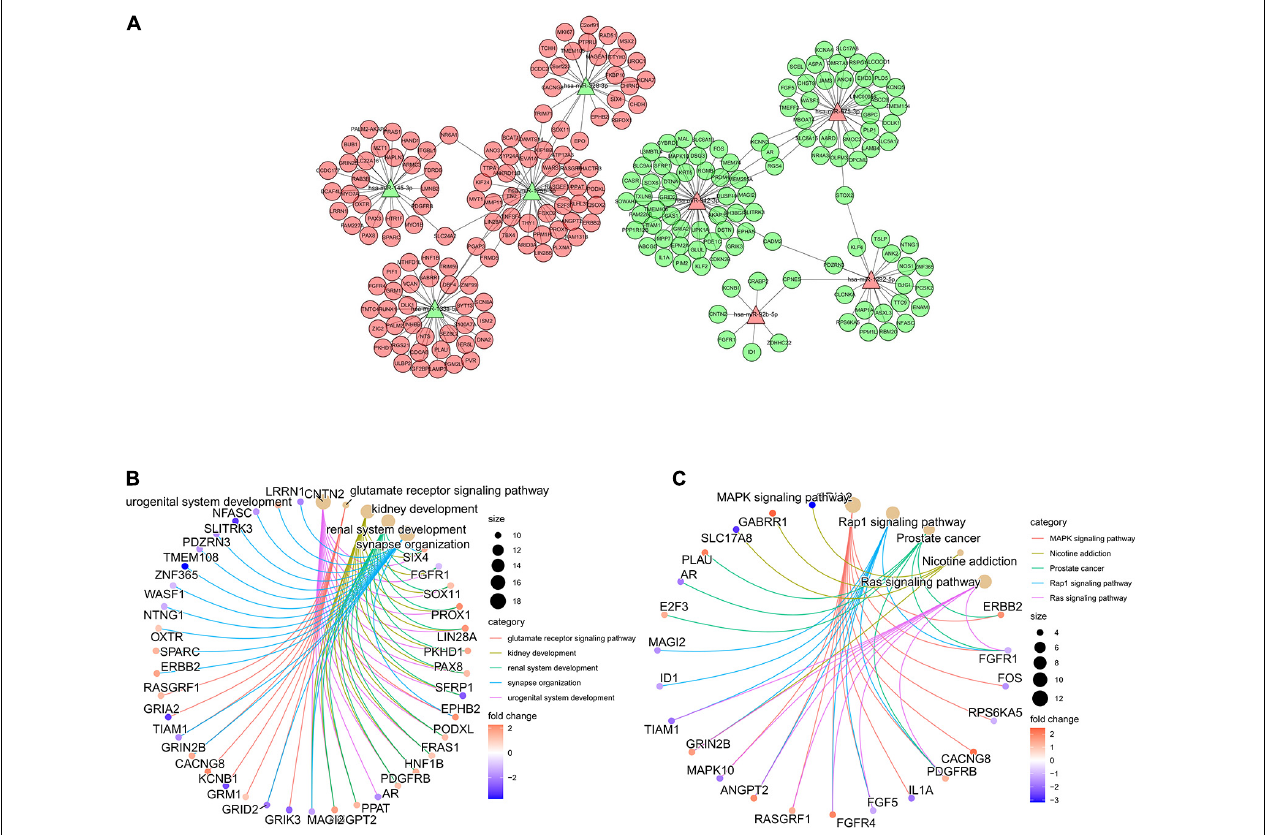
FIGURE 4 | Functional analysis of the ImmiRSig. (A) Coexpression network of miRNA-target. (B) GO enrichment analysis. (C) KEGG enrichment